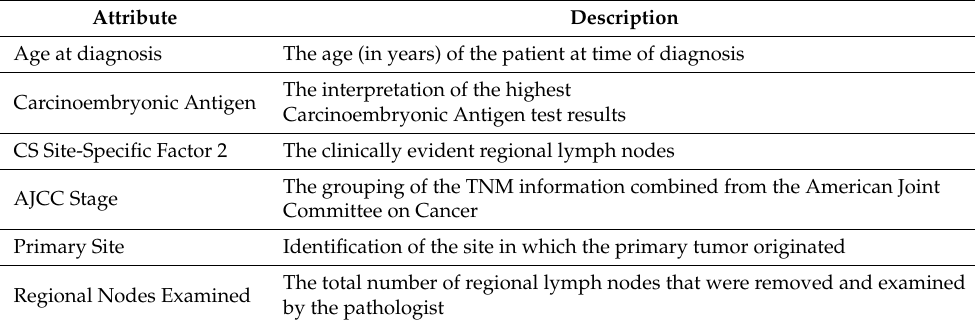
Table 4. Attributes retrieved by attribute selection and used for colon cancer